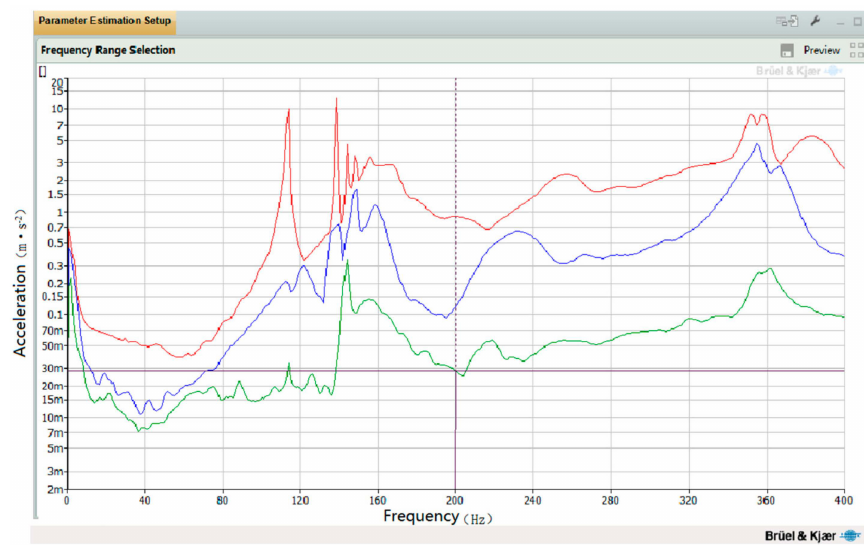
Figure 4. Spindle rotor frequency response function.